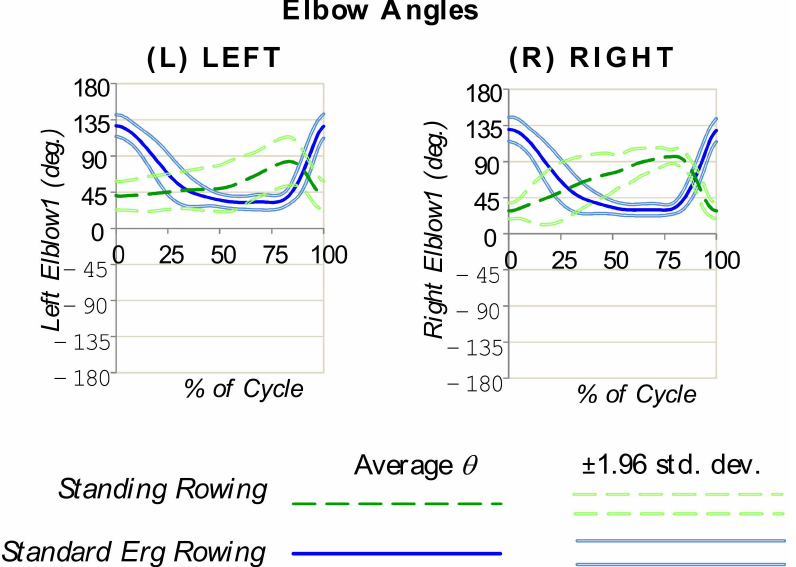
Figure 12. The averaged angular measurements for the elbow (sagittal) from the laboratory study, reported as mean ± 1.96 s.d., which compares standing rowing (green) with standard ergometer sliding-seat rowing